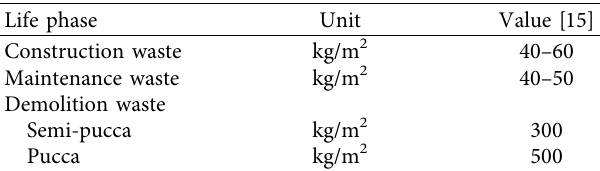
Figure 6: The percentage distribution of bioproductive land consumed in the EF m . Table 10: C&D waste generation during life phases of typical Indian